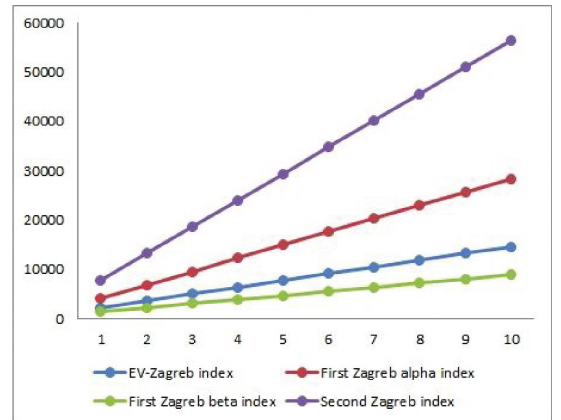
Figure 5: Graphical comparison of HNN-2.